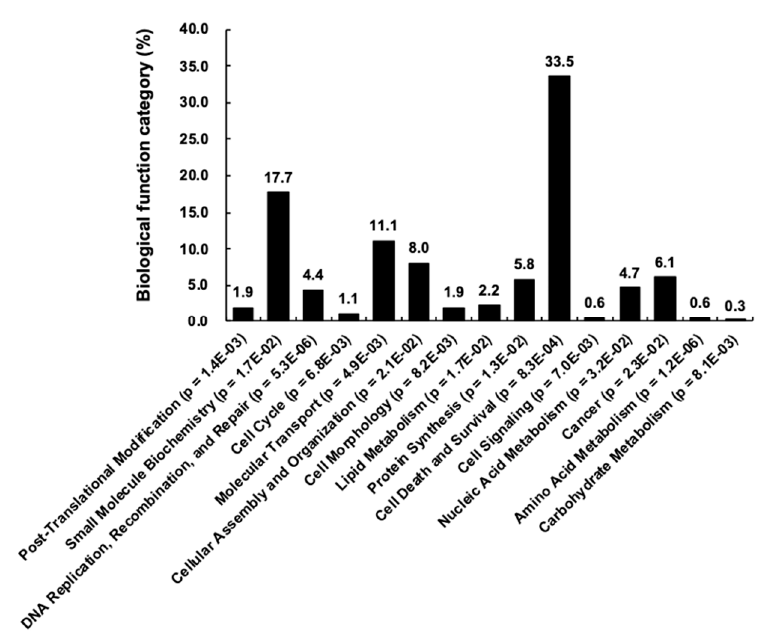
Figure 5. Gene ontology classification. The graph shows biologic function categories of the kinase interactome (28 kinases and 676 genetic interaction partners). The y-axis indicates the percentage in each category.